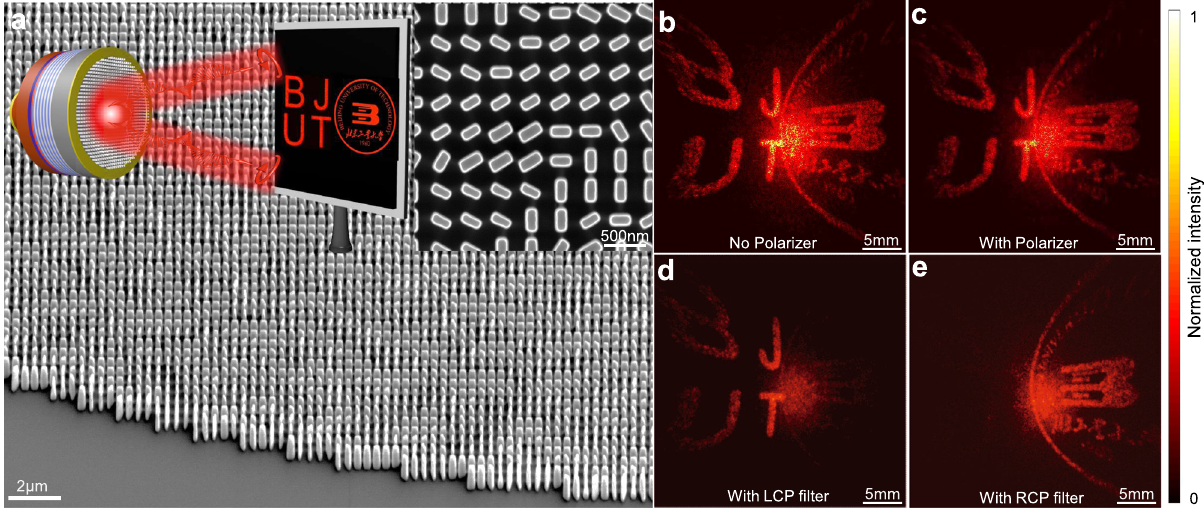
Fig. 2 | Spin-decoupled holographic VCSEL. a SEM images of the integrated holographicmetasurface,revealingthehighaccuracyofthedevelopedintegration process. The inset schematically summarizes the example of dual-channel holo- graphic design to structure the far- fi eld intensity pro fi les of the spin-decoupled VCSEL into two CP channels, in which two infrared images of the letters of “ BJUT ” andtheuniversitylogoweredirectlyprojectedontoawhitescreenforobservation.